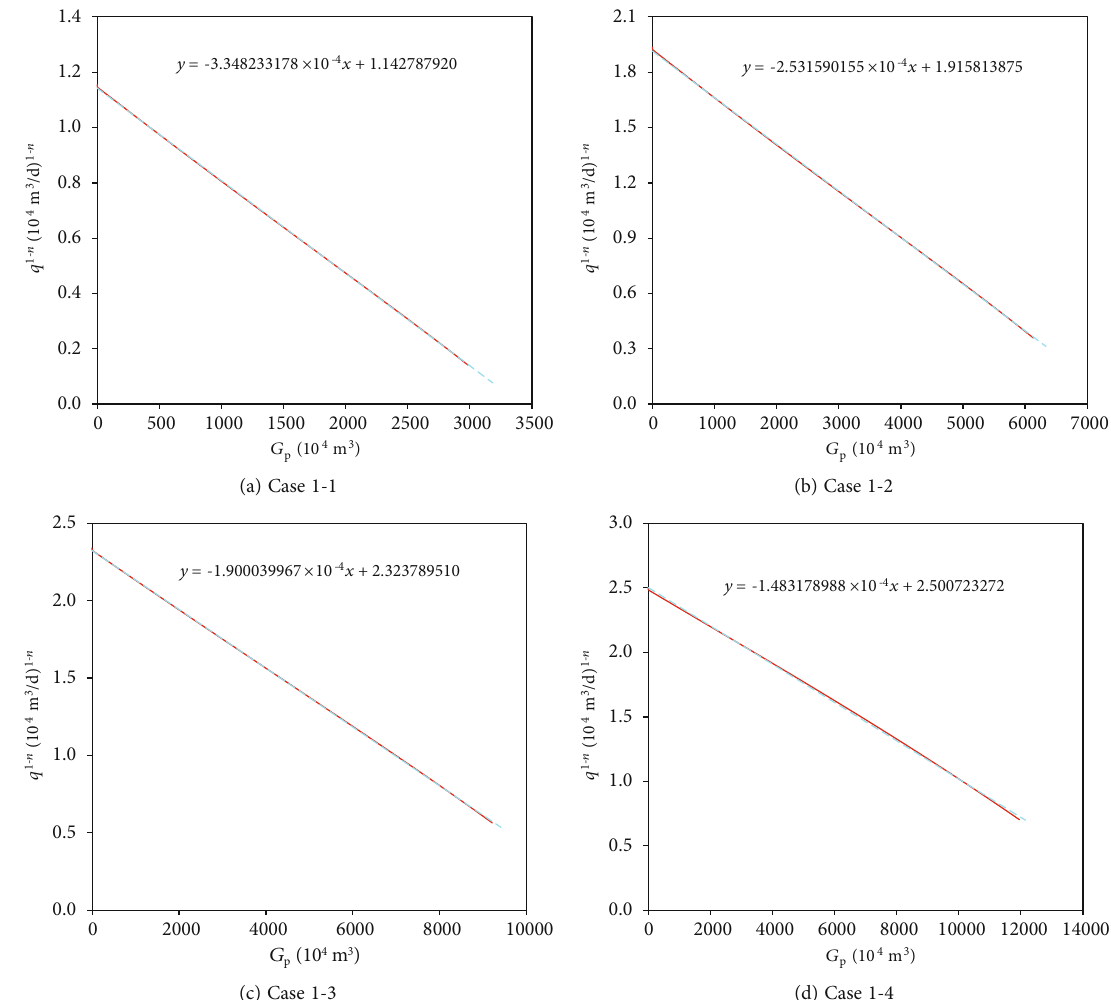
Figure 34: q 1 − n vs. G for the simulated gas reservoir with normal p